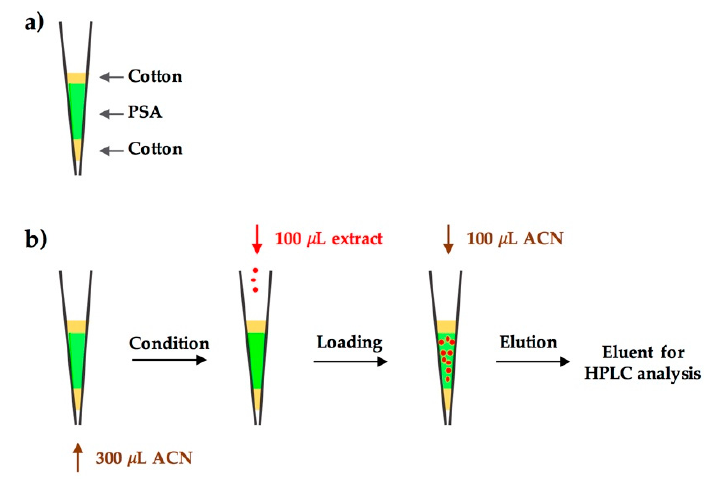
Figure 5. Schematic of ( a ) the DPX device, and ( b ) the optimal DPX procedure.